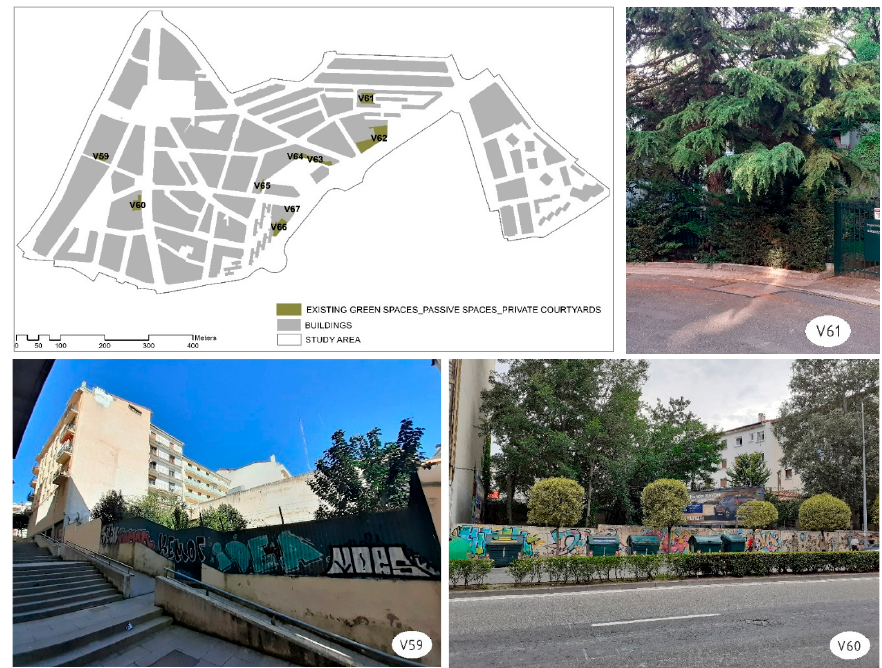
Figure 8. Existing passive green spaces: roundabouts and central reservations. On the other hand, there is a group of small gardens in courtyards and private plots that occupies a surface area of 5479.9 m 2 (Figure 9).